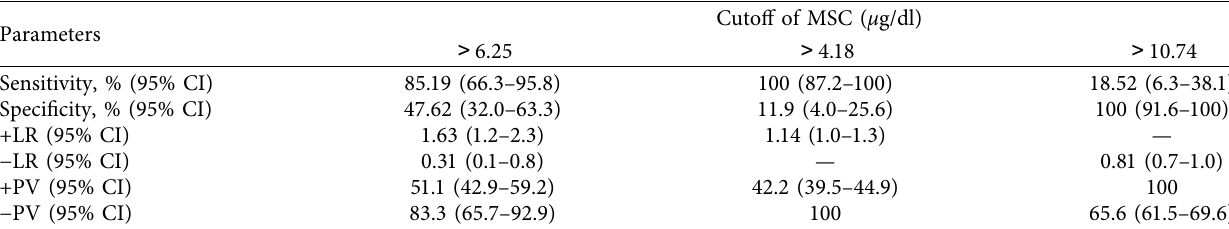
Figure 2: ROC curve of MSC and MSC combined with the postoperative course in the diagnosis of CAS. (a) ROC curve of MSC in the diagnosis of CAS. (b) ROC curve of MSC combined with the postoperative course in the diagnosis of CAS. ROC, receiver operating characteristics; AUC, area under the curve; CAS, central adrenal sufficiency. Table 3: Diagnostic efficacy of MSC for the recovery of HPA